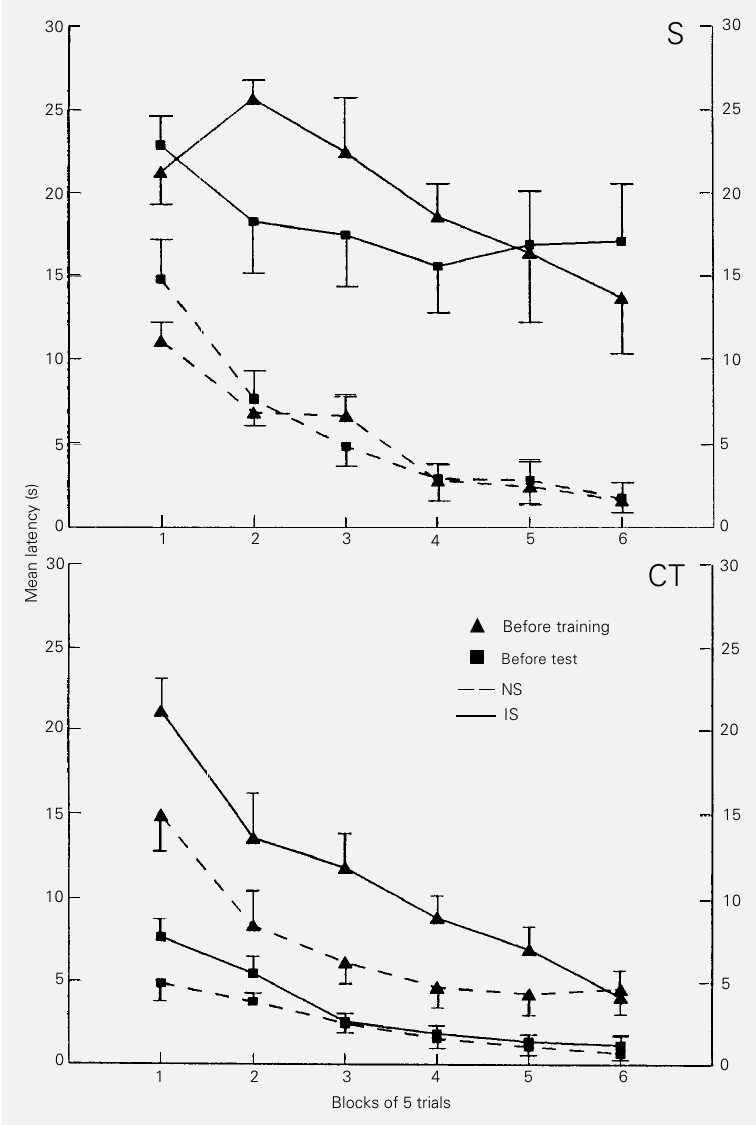
Figure 2 - Cross-tolerance to morphine prior to the test session reverses learned helpless- ness. Data are reported as the mean escape latency (s) – SEM for blocks of 5 trials for 5-15 rats in each group. The rats were made cross-tolerant (CT) to morphine or received saline (0.9%, S) before the training or test session and were given either inescapable (IS) or no shocks (NS) in a shuttle